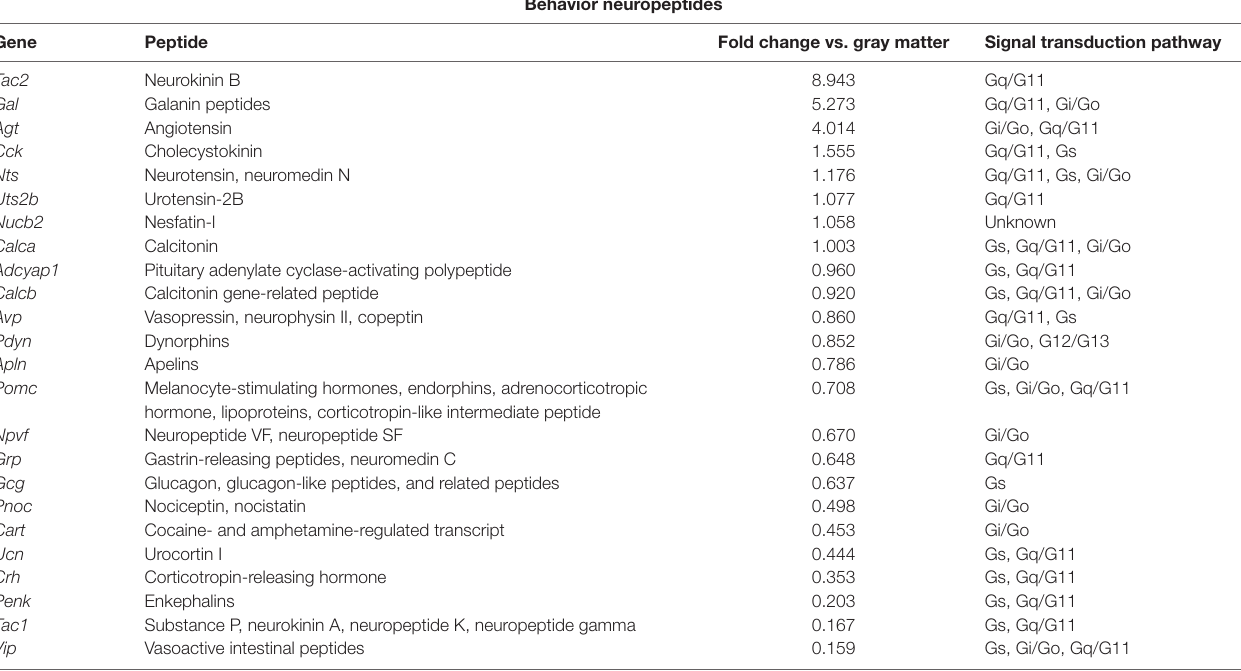
TABLE 1 | Neuropeptides in the paraventricular nucleus of the thalamus (PVT) with known roles in behavior, as identified with the Allen Brain Atlas.